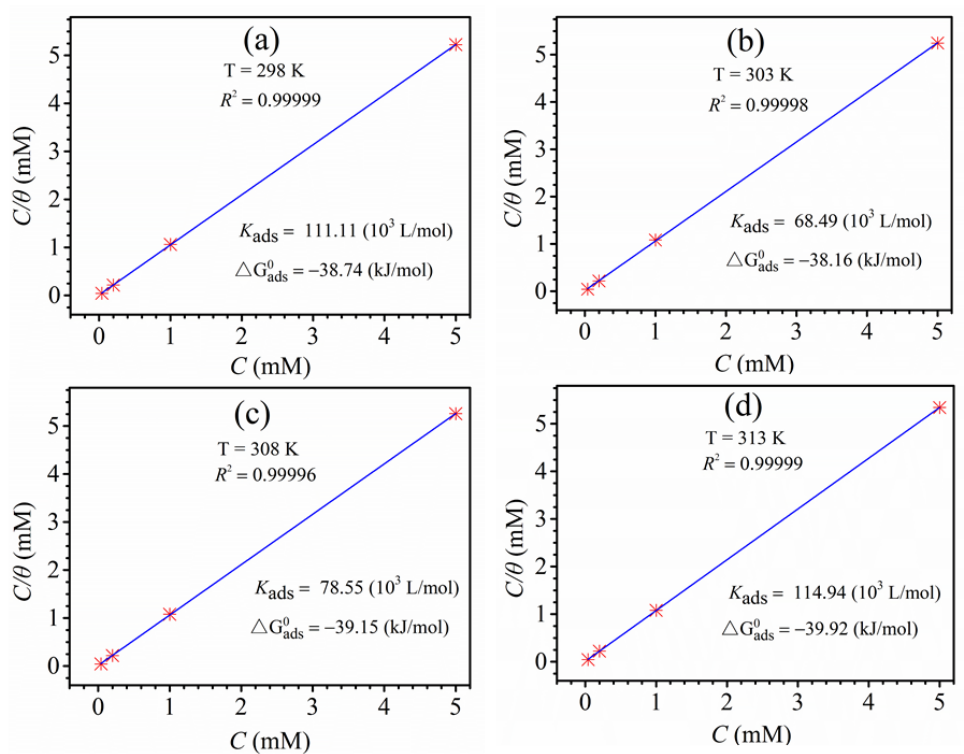
Figure 9. The Langmuir isotherm equation plots of copper with different concentrations of itraconazole in 0.5 mol/L H 2 SO 4 at diverse temperatures.